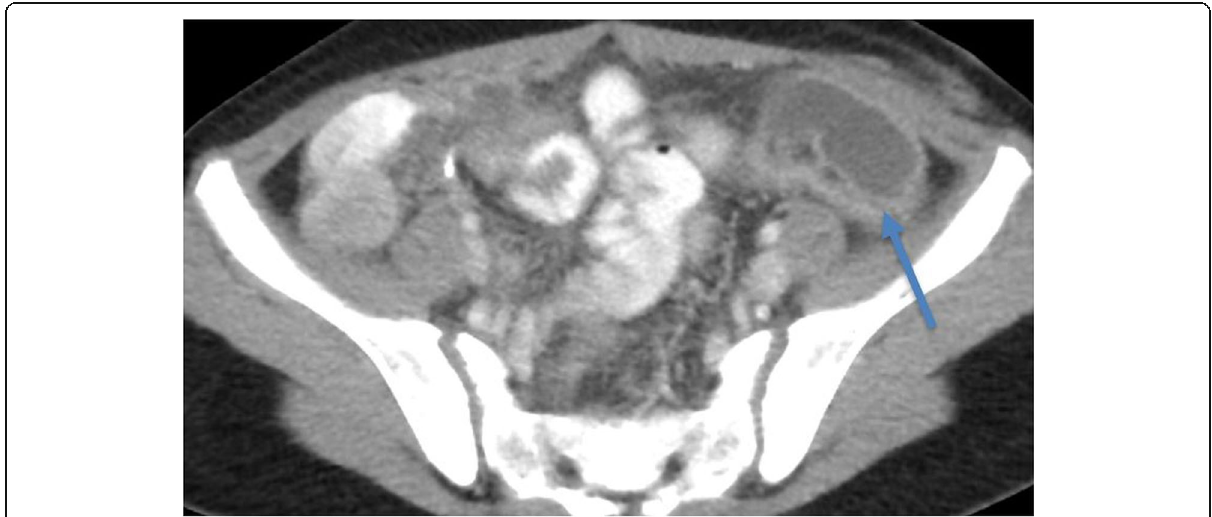
Fig. 2 Transverse abdomen CT image of a 14 yrs. M (42 kg) acquired at 4.4 mGy. Interloop abscess (arrow) and overall image quality scored optimal (scores 3 or 4) by all readers